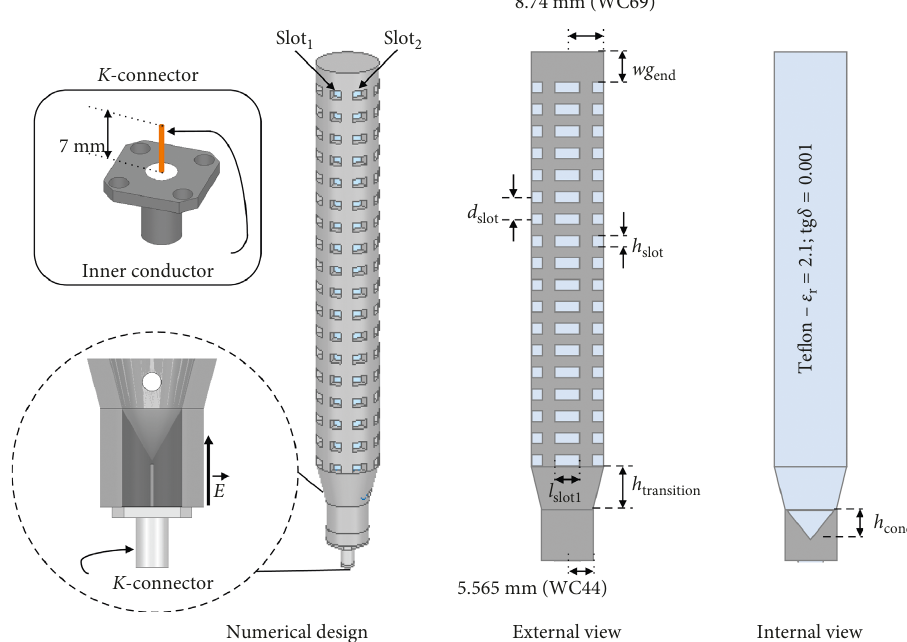
Figure 2: Novel SWAA design based on trapezoidal-shaped slots with two different electrical